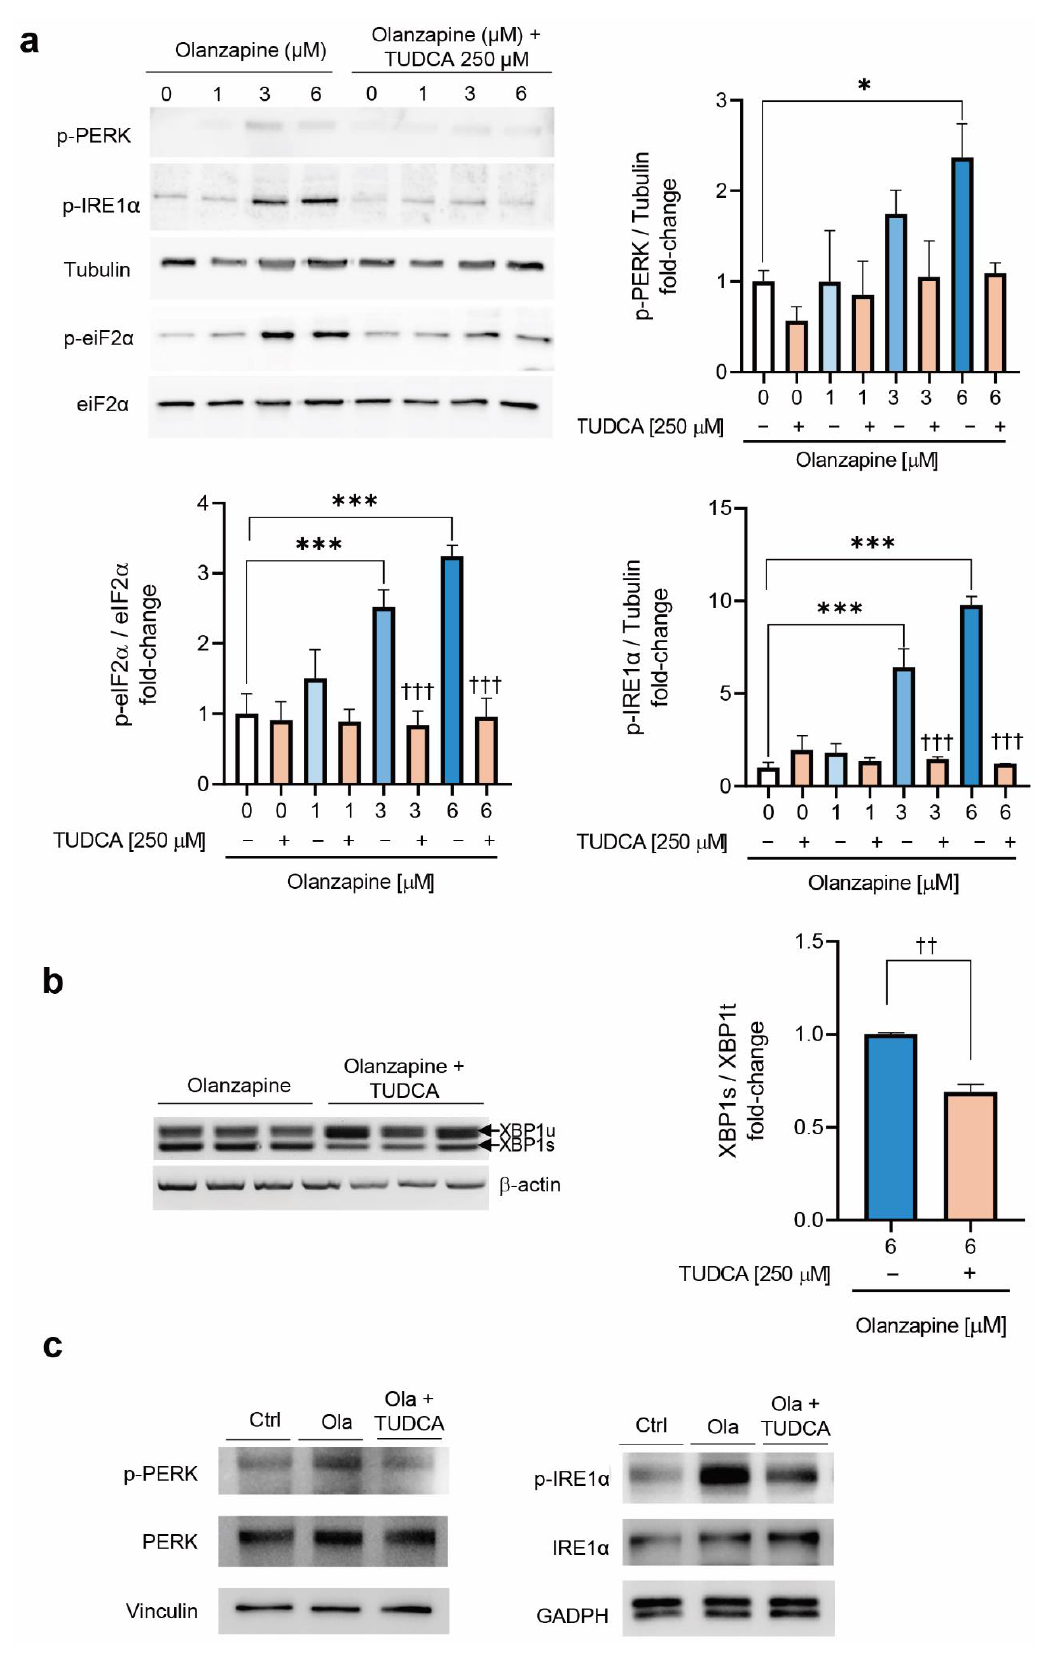
Figure 4. Alleviation of olanzapine-induced ER-stress-mediated signaling by TUDCA in INS-1 cells and pancreatic islets. ( a ) PERK, IRE1 α and eIF2 α phosphorylation in INS-1 beta cells upon